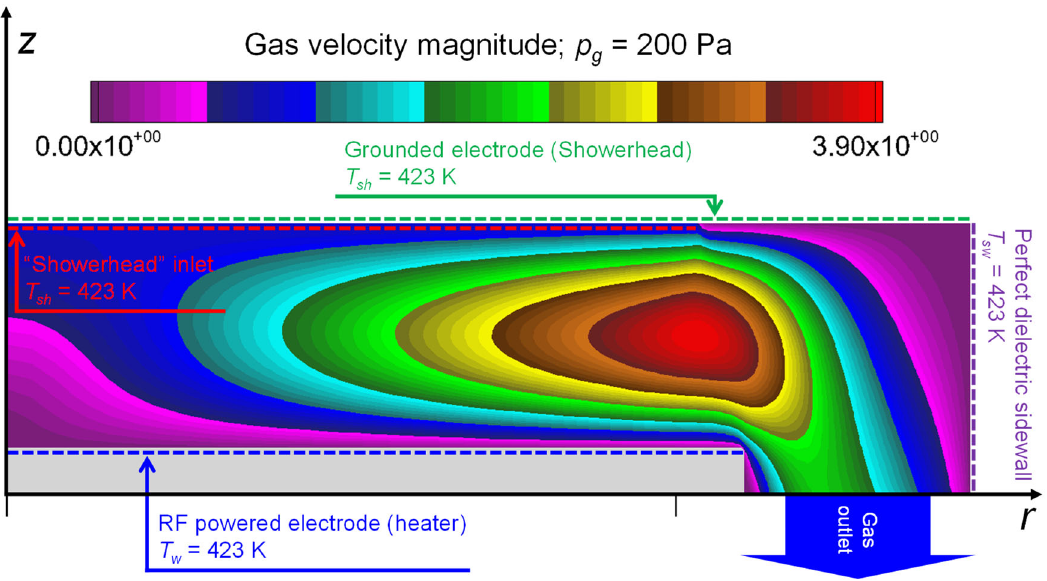
Figure 1. Schematic diagram of our CCP reactor. Spatial variation in the gas velocity magnitude ( V m , m s − 1 ) is depicted for Case 1. m s − 1 ) is depicted for Case